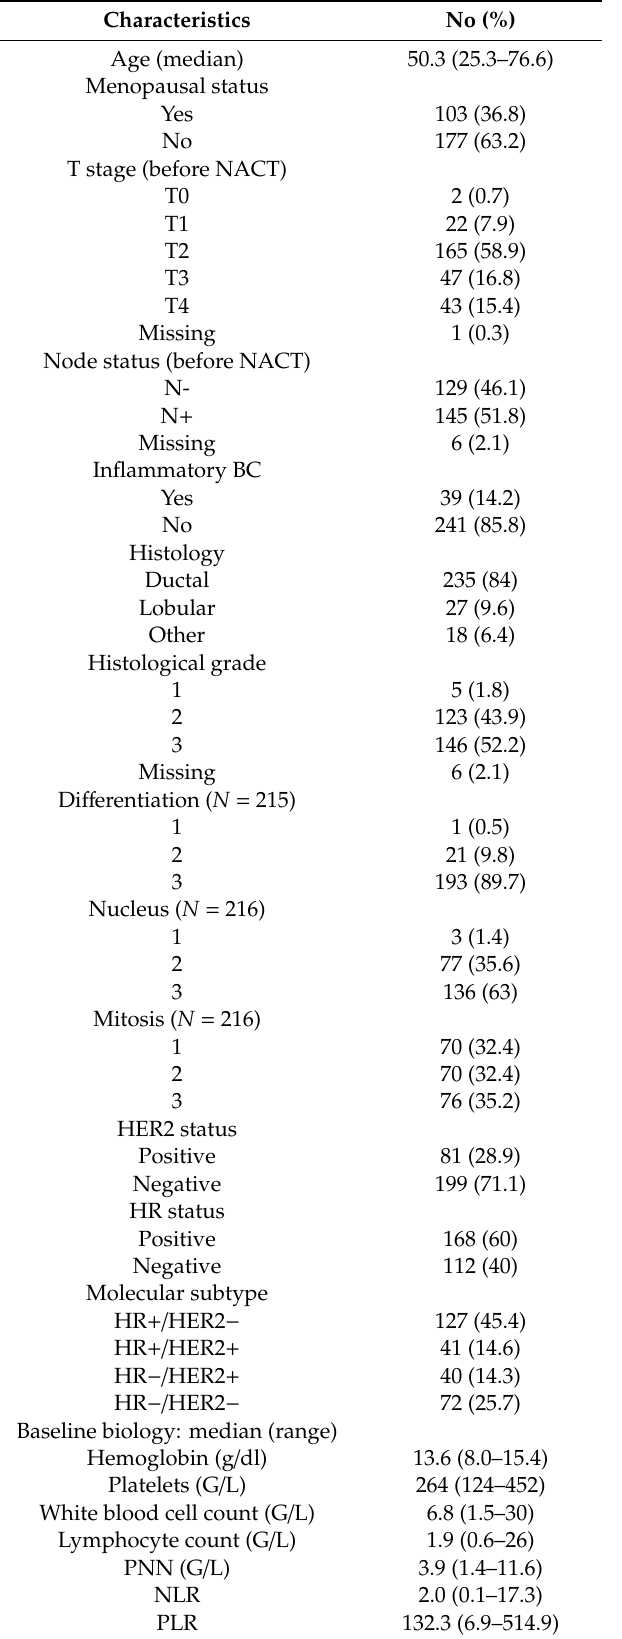
Table 1. Patients’